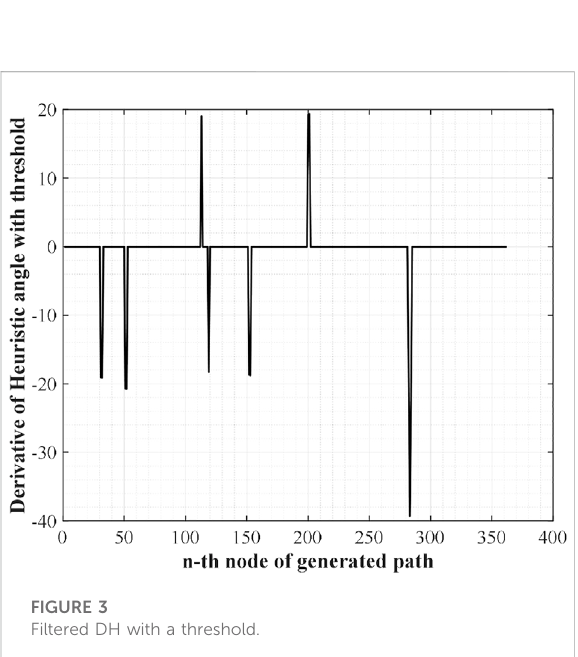
FIGURE 3 Filtered DH with a